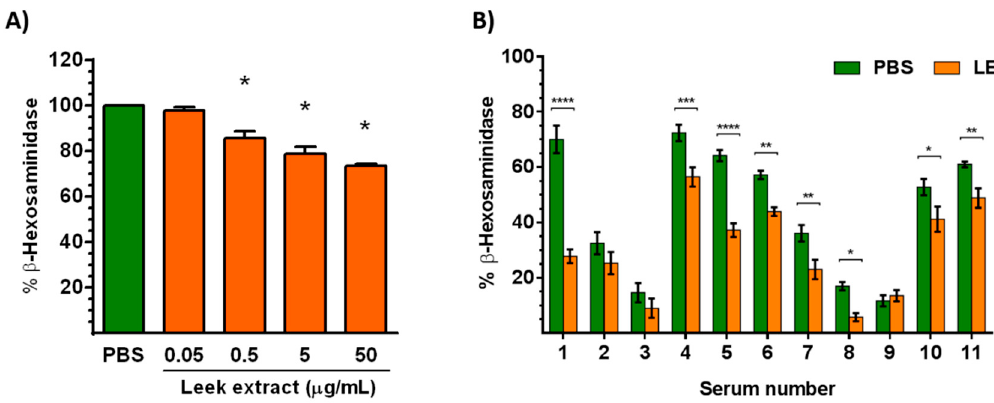
Figure 2. Measurement of β -hexosaminidase after the activation of ( A ) human mast cells LAD2 with the compound 48 / 80 (5 µ g / mL) and ( B ) HumRBL-2H3 with Ole e 1 (25 ng / mL) after treatment with leek extract (LE) − 0.05–50 µ g / mL ( A ) or 5 µ g / mL ( B ) for 48 h. HumRBL-2H3 were previously sensitized with sera from patients allergic to Ole e 1. * p < 0.05, ** p < 0.01, *** p < 0.001, **** p < 0.0001 compared to control cells treated with PBS.